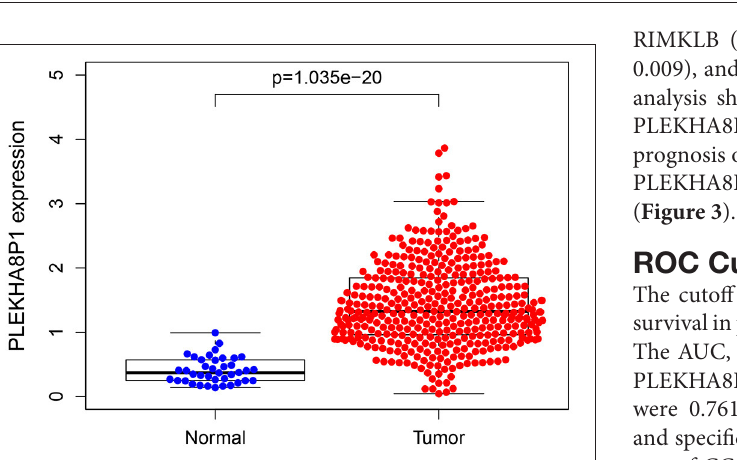
FIGURE 2 | Forest plot of the correlation of prognostic-related genes and clinicopathological features with overall survival among patients with colon cancer. * P < 0.05, ** P < 0.01, *** P < 0.001.